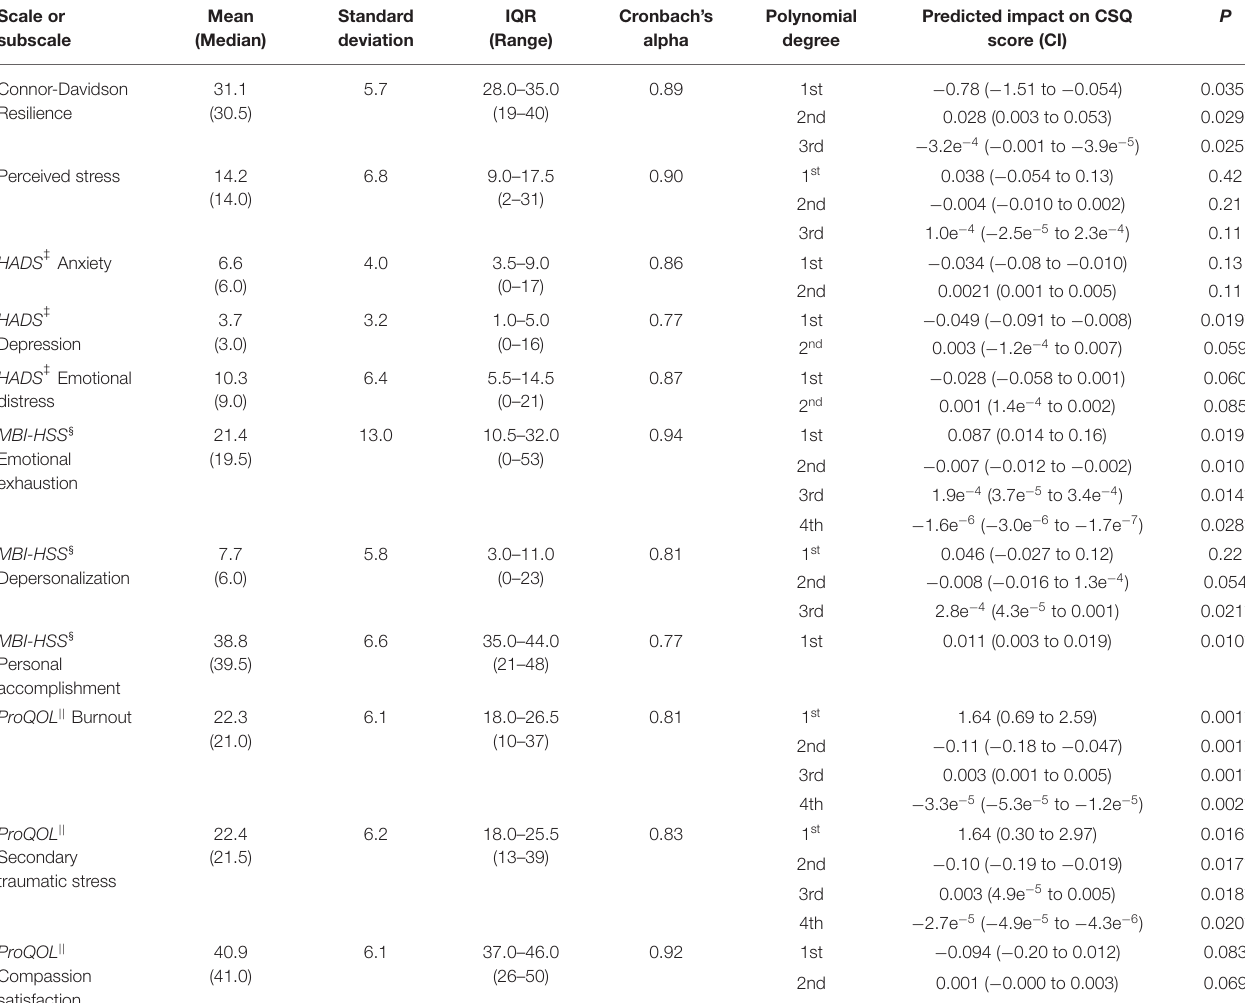
TABLE 2 | Mental health outcome scores of participating veterinarians ( n = 60) and predicted impact on Client Satisfaction Questionnaire (CSQ) score ( n = 995) in multilevel, univariable linear regression. Scale or